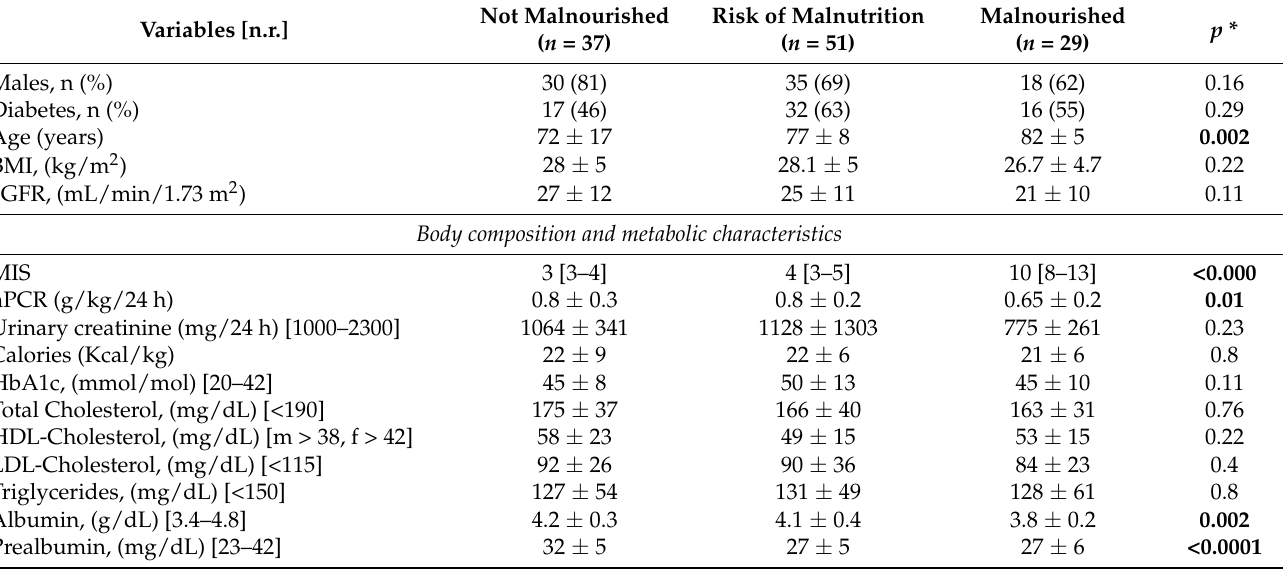
Table 2. Comparison of general characteristics and nutritional parameters between not malnourished, at risk of malnutrition and malnourished patients.